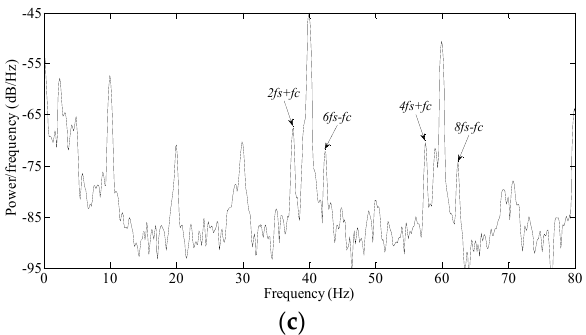
Figure 14. The squared envelope spectrum of stator current: ( a ) voltage frequency ratio 76 V/10 Hz; ( b ) voltage frequency ratio 38 V/10 Hz; ( c ) voltage frequency ratio 19 V/10 Hz.